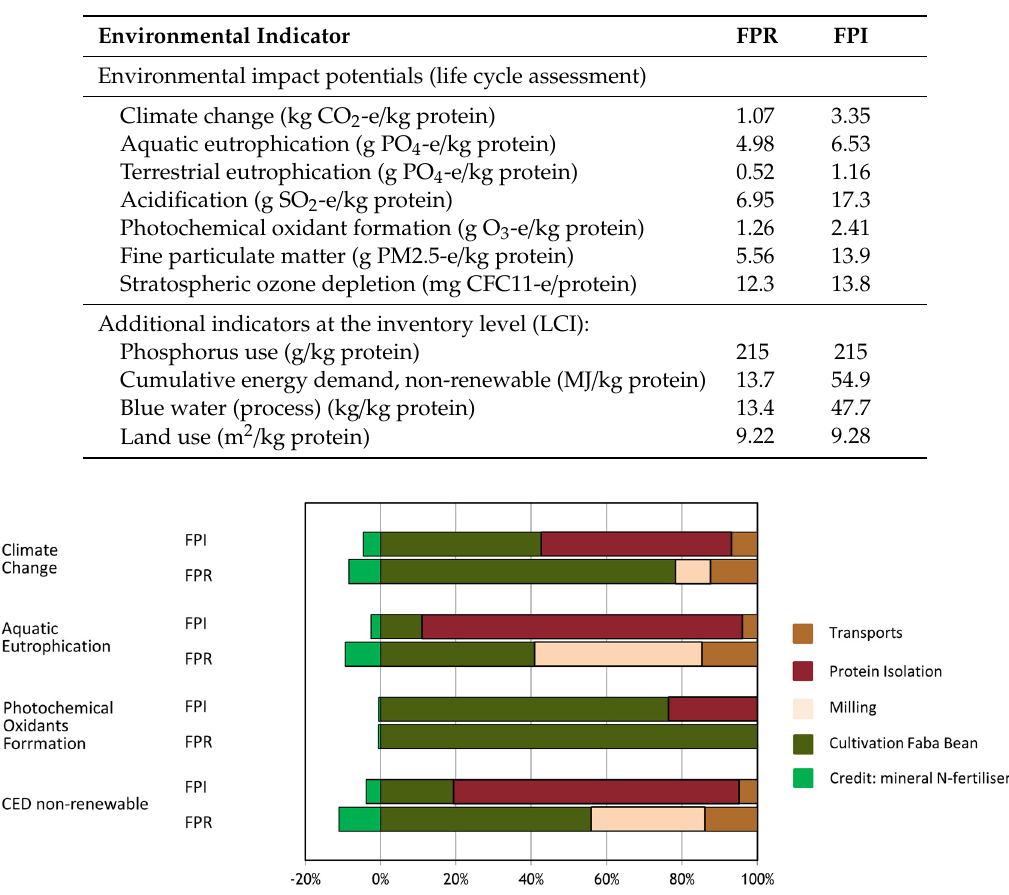
Table 8. Environmental impact profile of FPR and FPI, with environment impact potentials expressed per kg protein.